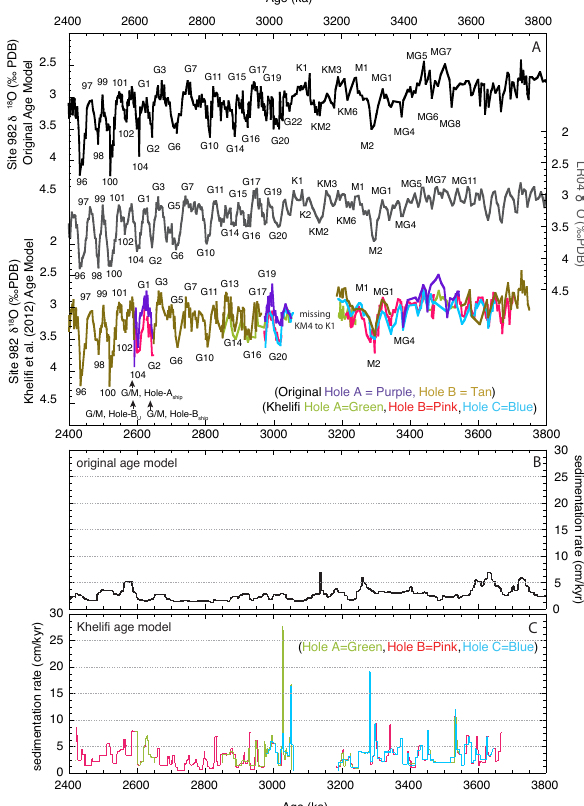
Fig. 2. ODP Site 982 isotopes and sedimentation rates: (A) oxy- gen isotopes from ODP 982 (Lisiecki and Raymo, 2005; Venz and Hodell, 2002) plotted on the original age model (black) and both the original and Khelifi et al. (2012) isotopes on rmcd s of Khelifi et al. (2012) (colors) with associated correlations of both age mod- els with the LR04 oxygen isotope benthic stack (gray) (Lisiecki and Raymo, 2005); (B) sedimentation rates at Site 982 estimated from the original age model (black); (C) sedimentation rates for holes A, B and C estimated from the age model proposed by Khelifi et al. (2012) (colors). Small black arrows and associated labels – lower left-hand corner of (A) – indicate the position of the Gauss– Matuyama chronozone reversal boundary from both shipboard and u-channel